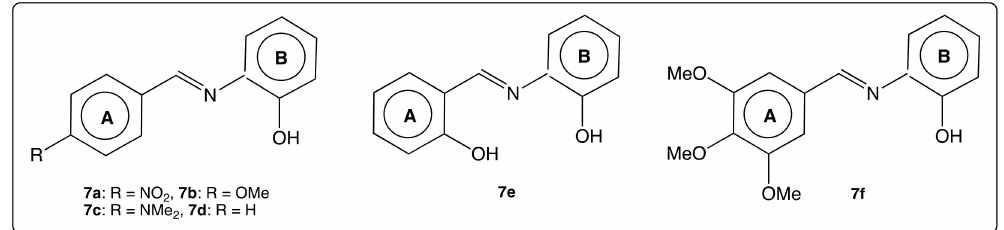
Figure 8. Suggested mechanism in the adduct of Keap1 protein on AZA-ST 3a and 6 . (Inspired from [33]).